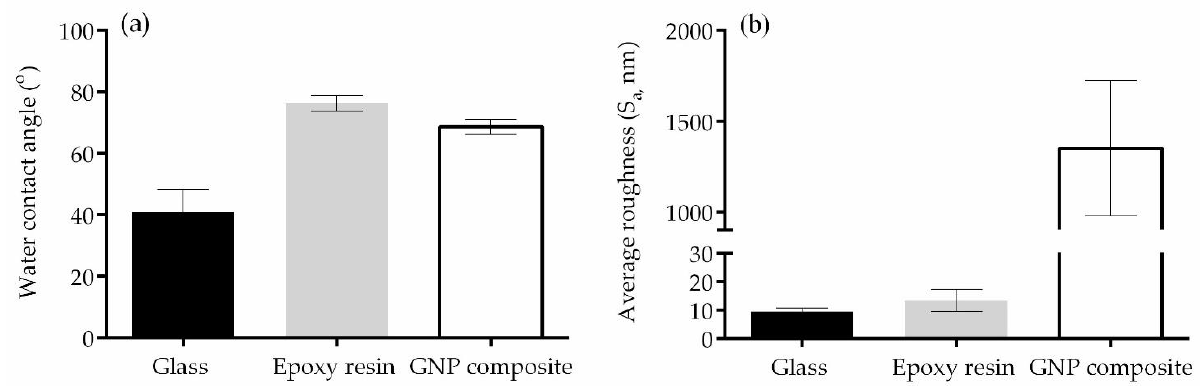
Figure 2. Water contact angles ( a ) and average roughness ( S a ) ( b ) of the tested surfaces. The means ± SD are shown.